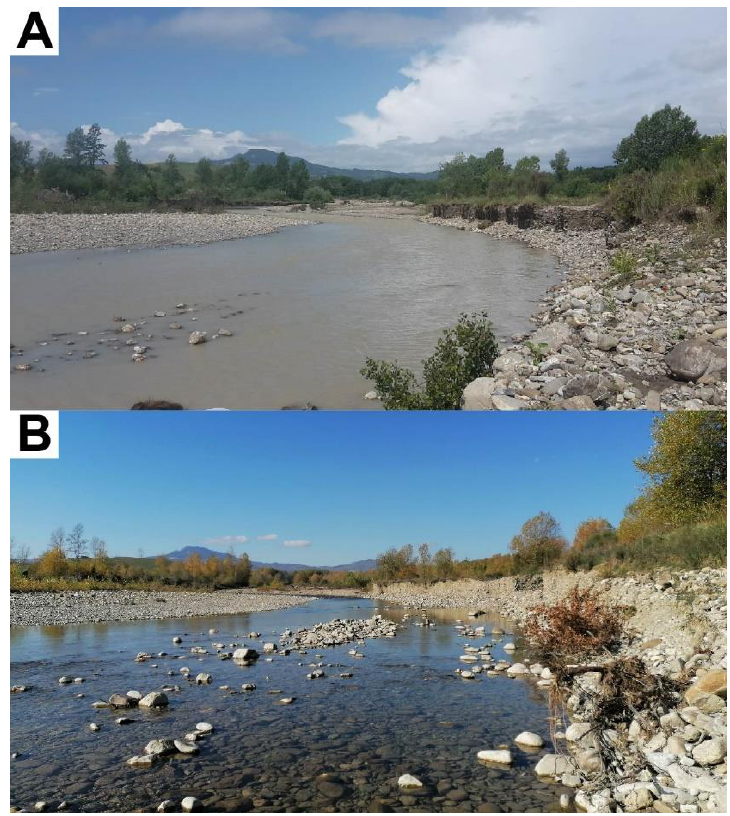
Figure 4. Water turbidity conditions in two different seasons at TP2 site. ( A ) In June 2020, after four intense rainy days; ( B ) in November 2020, after a period without significant precipitation.